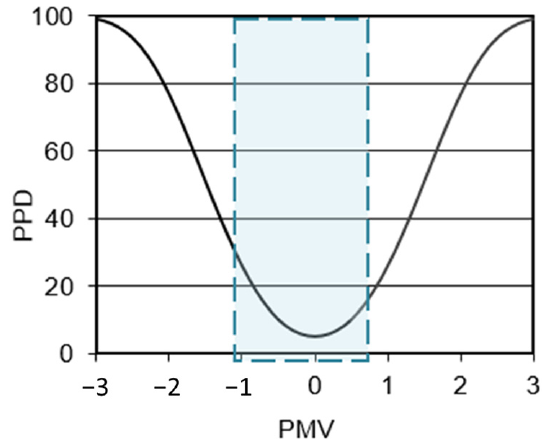
Figure 10. Comfort zone adopted in the present study.